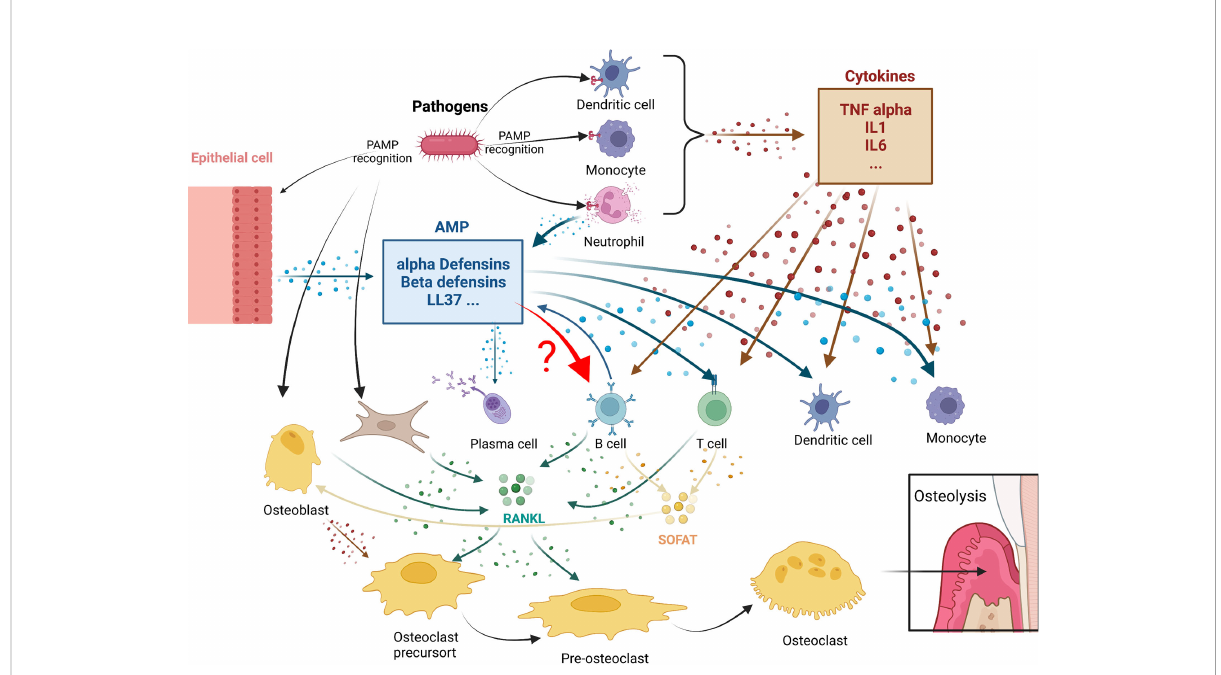
FIGURE 1 Antimicrobial peptides immunomodulation in periodontitis osteolysis: potential connections with leukocytes. In periodontitis, pathogens triggers both cytokines (in brown) or antimicrobial peptides (AMPS) (in blue) production. Both mediator ’ s categories are known to play roles in leukocytes actions. A crucial step in these diseases is the expression of RANKL and SOFAT. B and T cells, which are the main source of RANKL and SOFAT, are central in this orchestration of osteoclast differentiation and activity leading to osteolysis. The effect of AMPs in B in this environment still remain to be